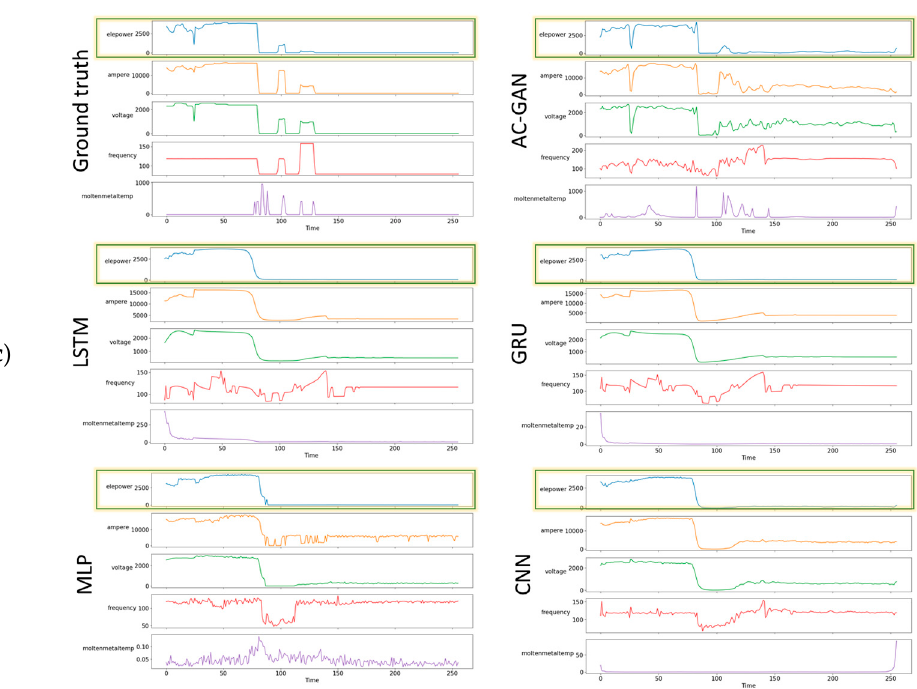
Figure 14. Visual comparison of melting process results: ( a ) input product type p1, ( b ) input product type p3, ( c ) input product type p6.